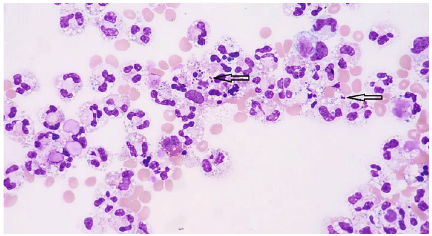
Figure 1: Pericardial fl uid Giemsa stain at 400 × magni fi cation, arrows show variably sized round, fragmented elements with “ budding.